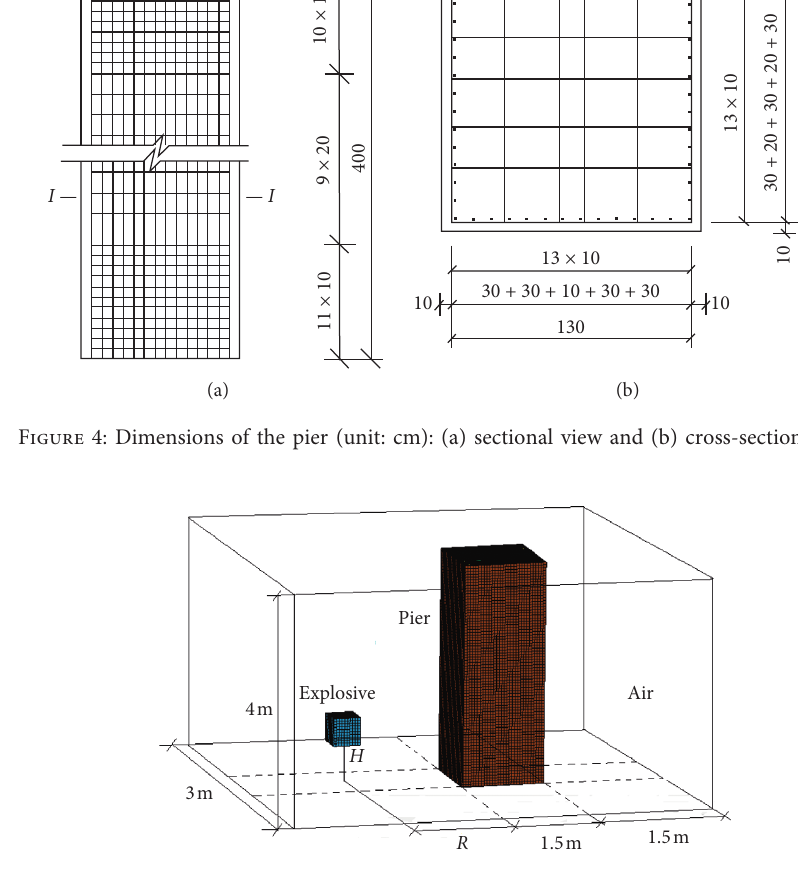
Figure 5: FE model of the pier under explosion load. Table 2: The mesh sizes and material properties.